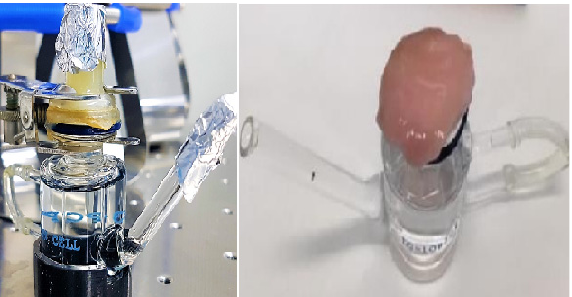
Figure 6. Vertical diffusion of Franz’s cell during the experiment ( left panel). Positioning of the porcine intestinal mucosa on the acceptor compartment of Franz’s cell ( right panel).